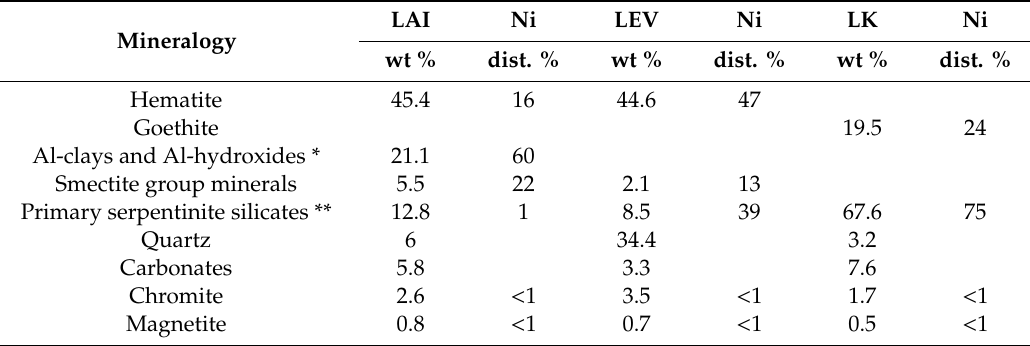
Table 2. Mineralogy of the samples and distribution of nickel in each main phase. LAI Ni LEV Mineralogy dist. % dist. % dist. % Hematite